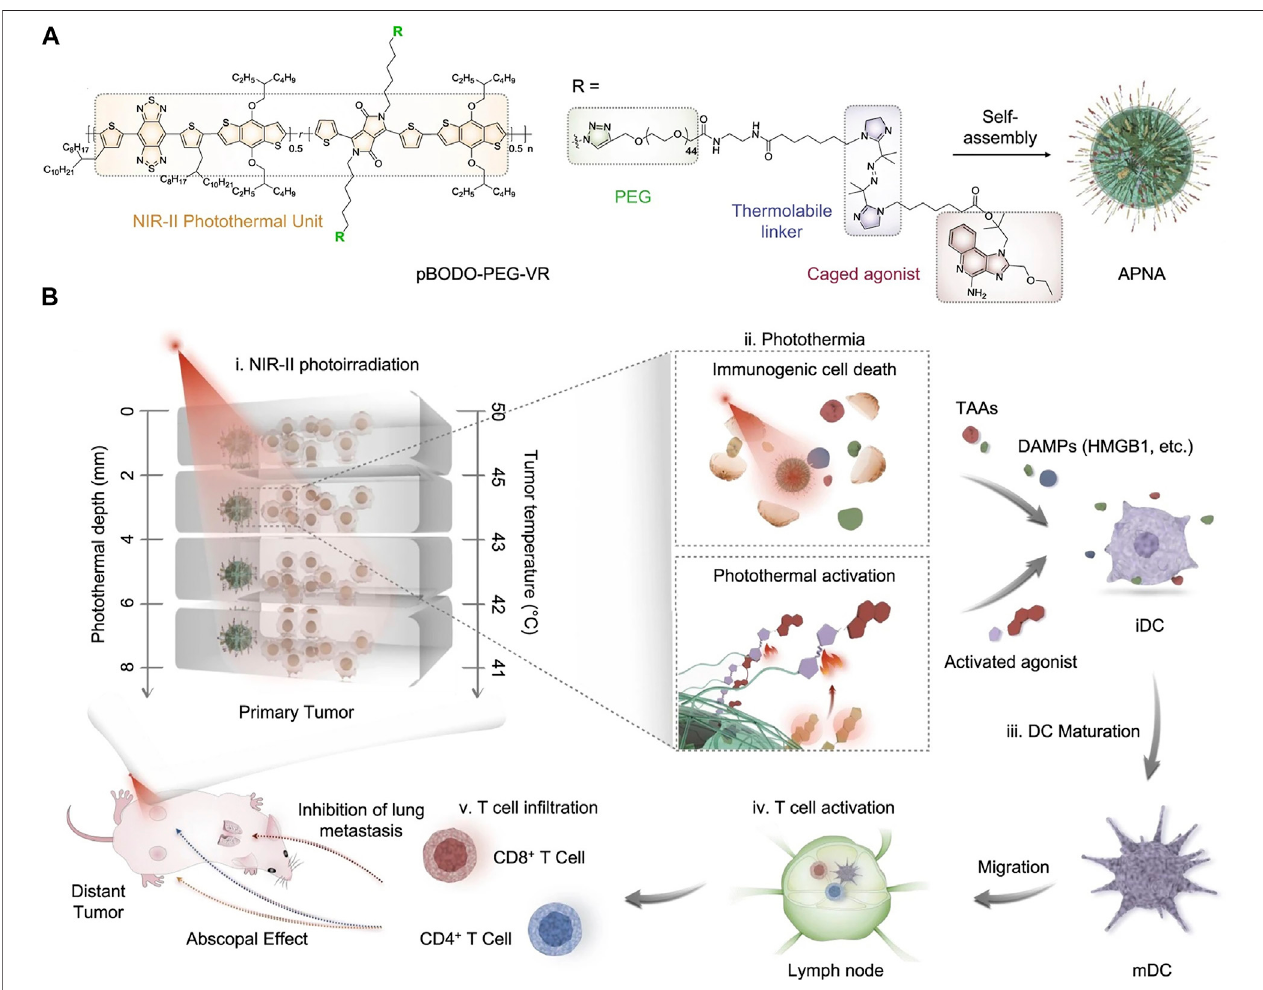
FIGURE 1 | (A) Chemical structure of NIR-II absorbing semiconducting polymer conjugated with R848 through a thermo-responsive linker and self-assembly of APNA. (B) Mechanism of antitumor immune response by APNA-mediated NIR-II photothermal immunotherapy. Reproduced, with permission, from Jiang et al. (2021). Copyright 2021, Nature Publishing